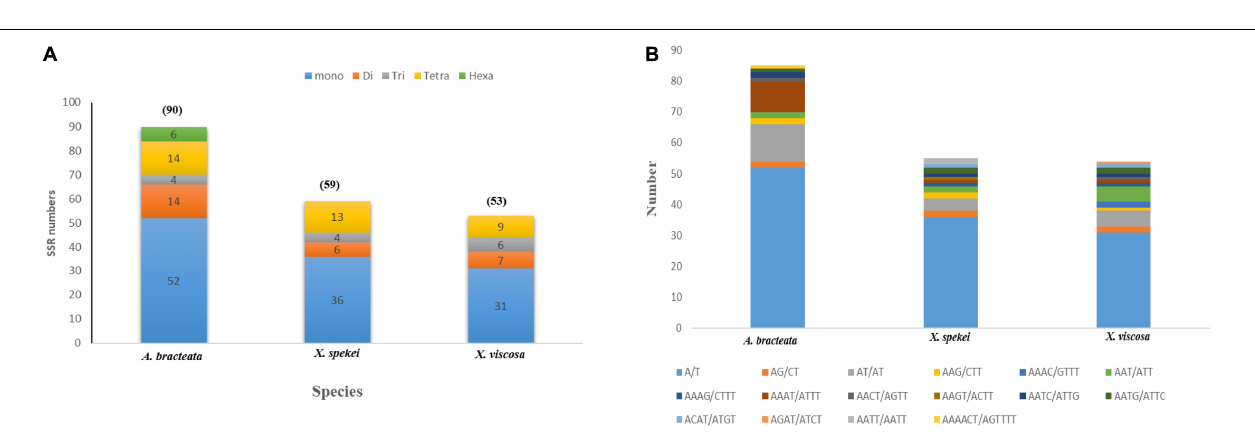
FIGURE 3 | Plastome simple sequence repeats (SSRs) in the three species. (A) Total number of different SSR types identified in each species; (B) the type and total number of each SSR.